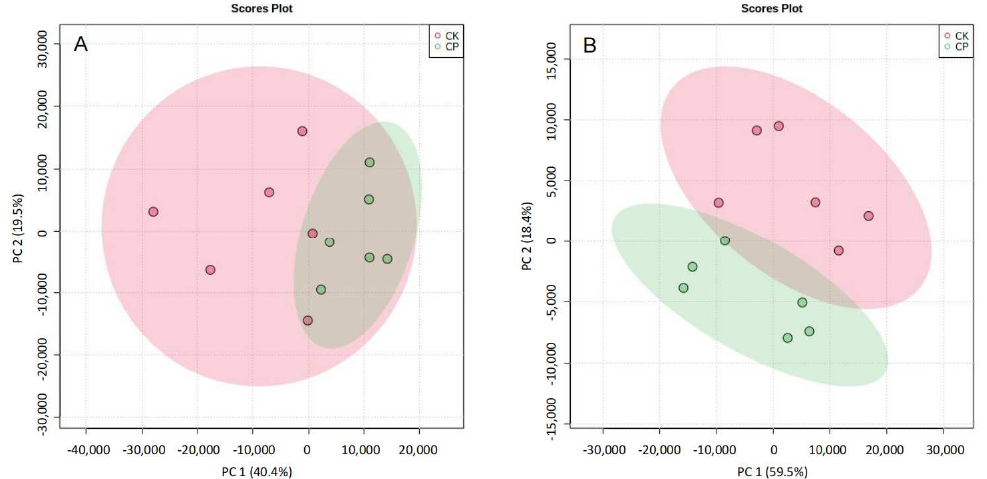
Figure 3. PCA score plots of amniotic fluid lipid profile in the CP and CK groups. Each dot represents an amniotic fluid sample ( n = 6). ( A ) Positive ion mode; ( B ) negative ion mode.